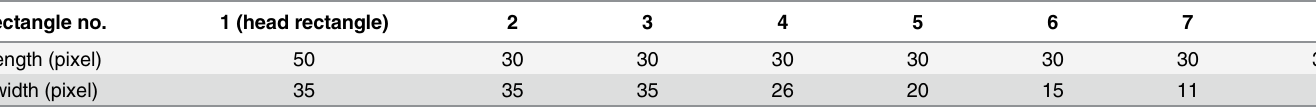
Table 1. Length and width of each rectangle. rectangle